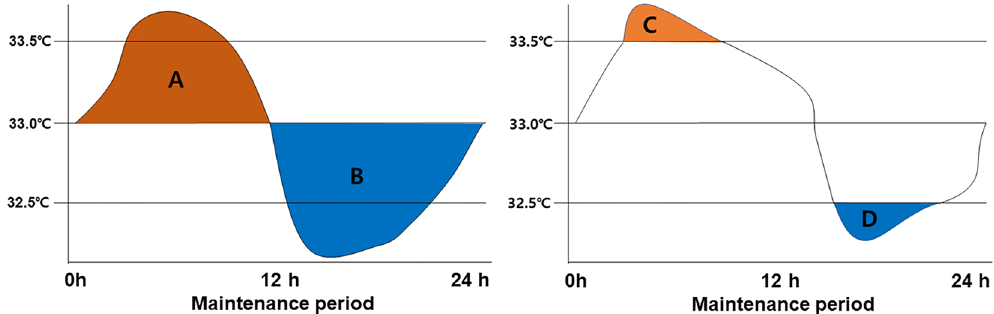
Figure 1. An example of time-weighted core temperature and core temperature variability during the 24 h of the maintenance period. The core temperature during the maintenance period was recorded every 1 min. Time-weighted core temperature was calculated to simultaneously quantify the degree of core temperature bias from the target temperature and exposure duration and is shown as a colored area. ( A ) Positive time-weighted core temperature. Degree and duration of core temperature above 33 °C. ( B ) Negative time-weighted core temperature. Degree and duration of core temperature below 33 °C. ( C ) Undercooling time-weighted core temperature over 33.5 °C. Degree and duration of core temperature above 33.5 °C. ( D ) Overcooling time- weighted core temperature under 32.5 °C. Degree and duration of core temperature below 32.5